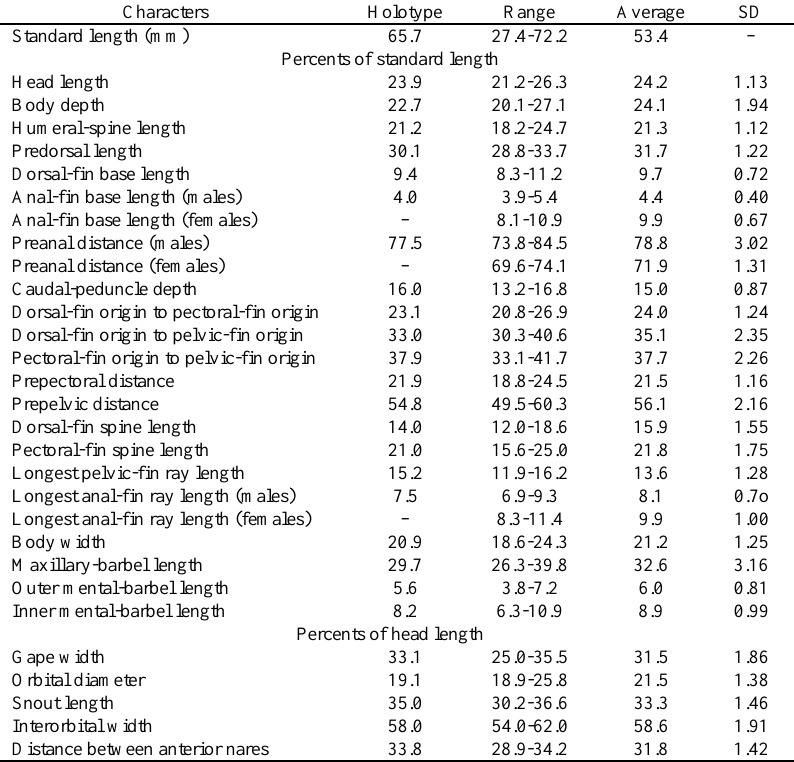
Table 1. Morphometric data of the holotype (male) and paratypes of Tatia jaracatia , from the lower rio Iguaçu basin (n = 43, including holotype). SD: standard